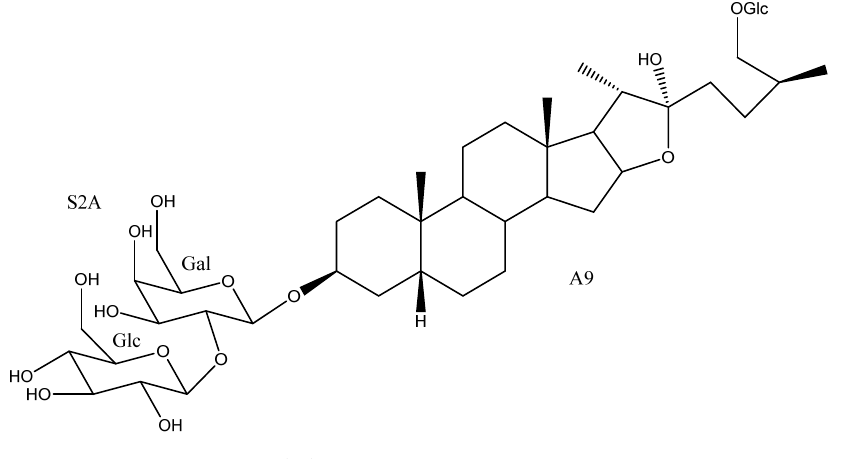
Figure 12. Timosaponin BII ( 50 ).